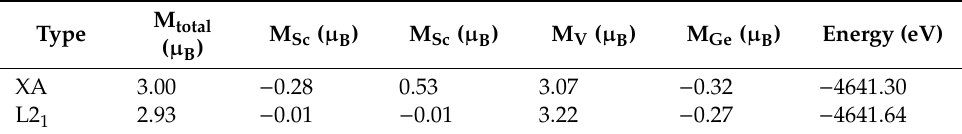
Figure 2. Between the lattice parameter and the total energy for Sc 2 VGe compound with XA and L2 1 structures. The energies in this figure were calculated per unit cell of Sc 2 VGe. Table 1. Calculated total and atomic magnetic moments and total energy for Sc 2 VGe compound. The energies in this table were calculated per unit cell of Sc 2 VGe.